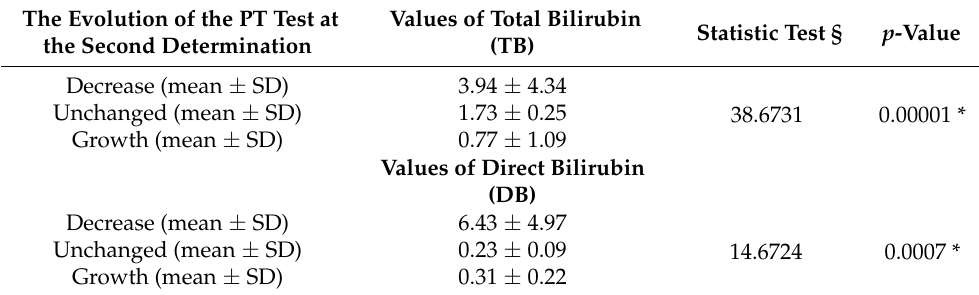
Table 7. Total Bilirubin (TB) and Direct Bilirubin (DB) values according to the evolution of the PT test at the second determination. The Evolution of the PT Test at